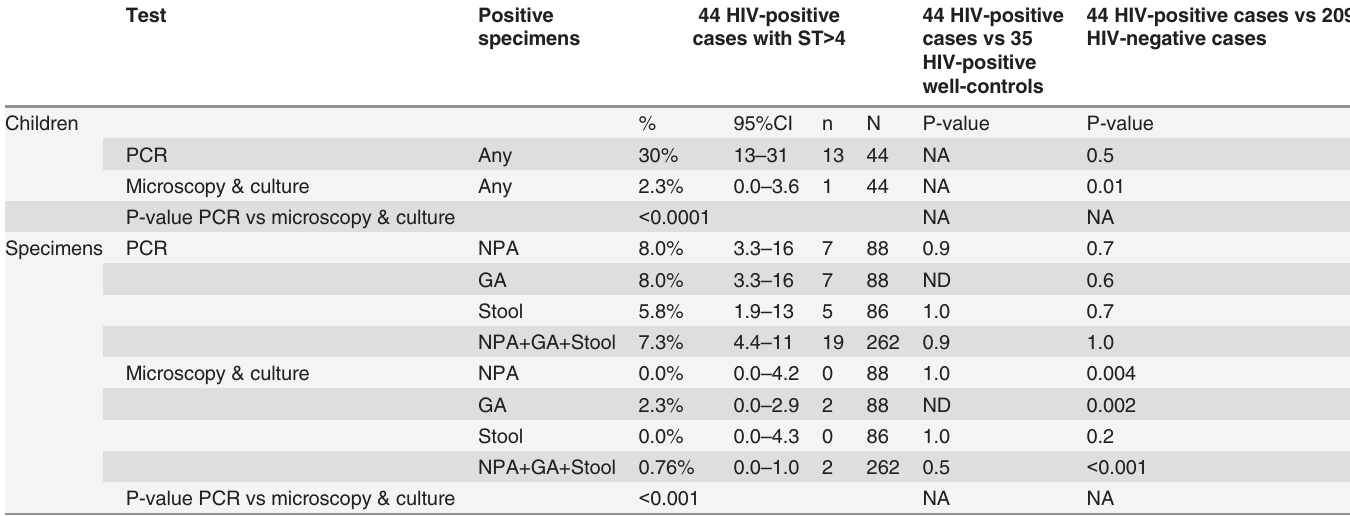
Table 3. PCR and culture